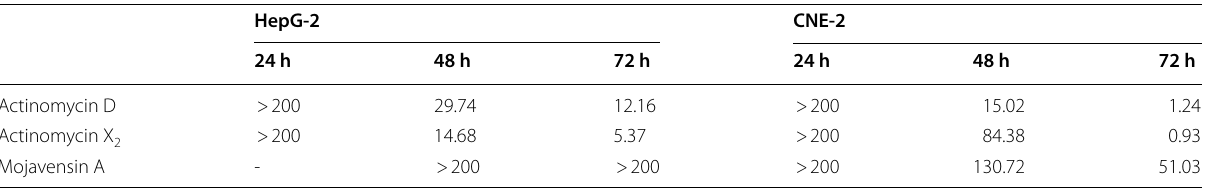
Table 4 The half-maximal inhibitory concentration (IC